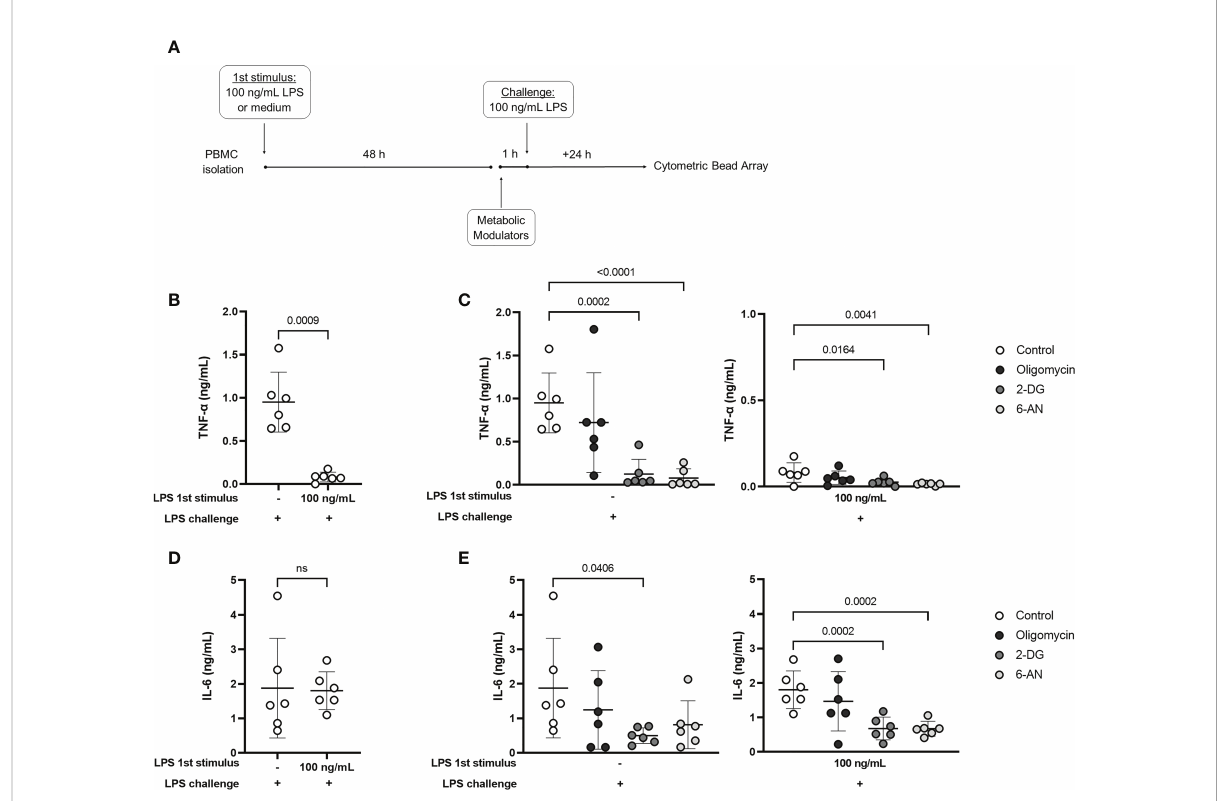
FIGURE 5 Glucose metabolism supports cytokine production in control and endotoxin tolerant PBMCs. (A) : PBMCs were incubated for 48h (1 st stimulus) with medium or 100 ng/mL of LPS, washed, and incubated for 1 h with 2-DG, 6-AN, and Oligomycin before challenge with 100 ng/mL LPS. TNF- a (B) and IL-6 (D) concentration in the culture supernatant of control (-) and endotoxin-tolerant PBMCs challenged with LPS. TNF- a (C) and IL-6 production (E) by control (-) and endotoxin tolerant PBMCs incubated with metabolic inhibitors along with LPS challenge. Graphs show mean and SD and each dot represents one individual donor evaluated in all experimental conditions (n = 6 donors); p-values indicate differences between each condition as measured by paired Student ’ s t-test (B, D) or repeated measures one-way ANOVA followed by Bonferroni posttest (C, E). ns, not signi fi